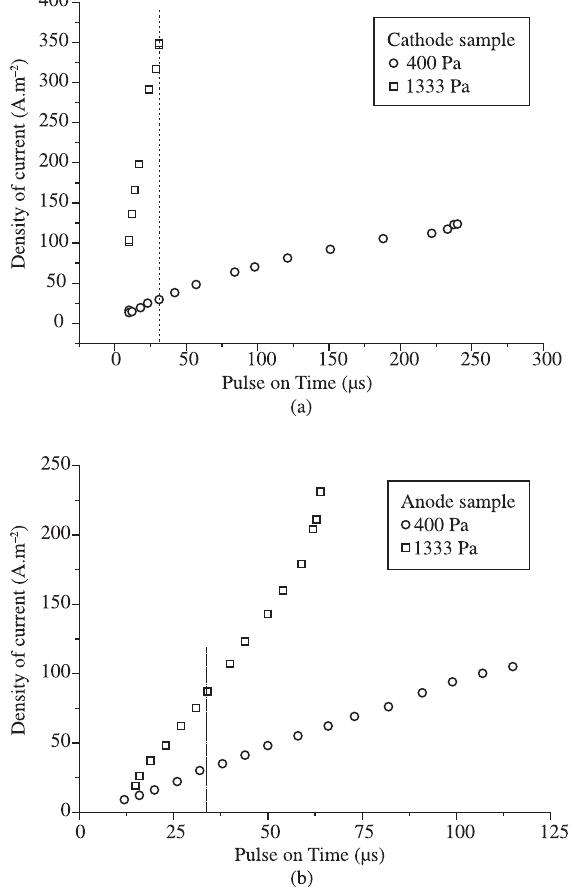
Figure 6. Behavior of the current density for the (a) CAC configuration and (b) CAN